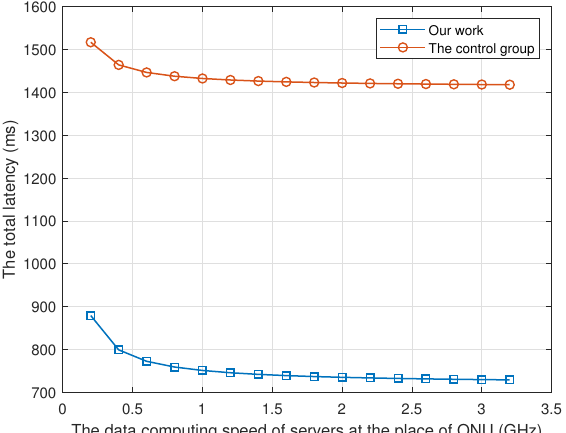
Figure 5. The total latency with MEC-1